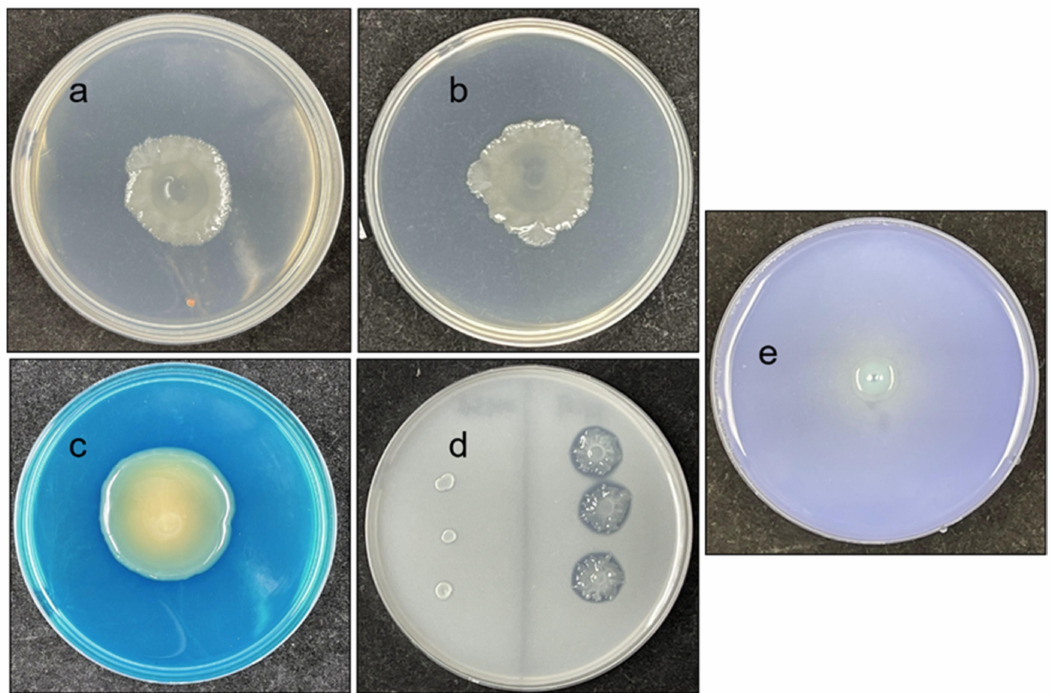
Figure 3. Identification of plant growth promoting traits of FY-07. ( a ), colony morphology of FY-07 on DF salt minimal medium without ACC added; ( b ), colony morphology of FY-07 on DF medium with ACC; ( c ), colony morphology of FY-07 on Modified CAS Agar Medium; ( d ), comparison of colony morphology between Escherichia coli MG1655 (left) and FY-07 (right) on Jensen’s medium; ( e ), colony morphology of FY-07 on Pikovskaya